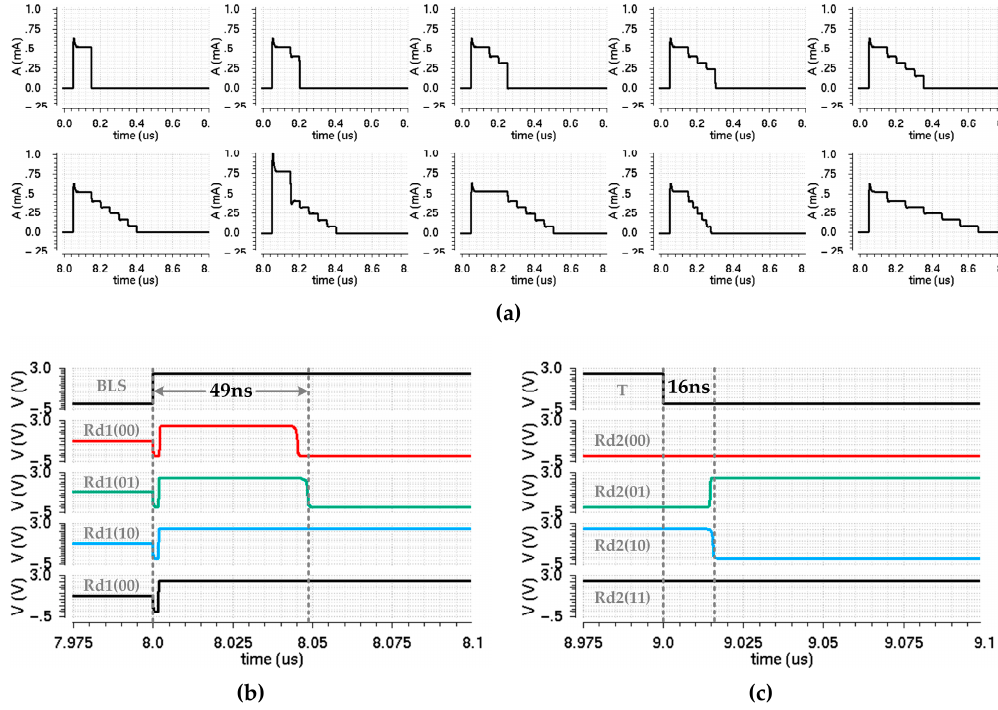
Figure 13. ( a ) Simulation graphs of the ramp-down current pulse generator circuit; ( b , c ) readout simulation results of four states in the phase change memory (PCM) cell during the two read operations.